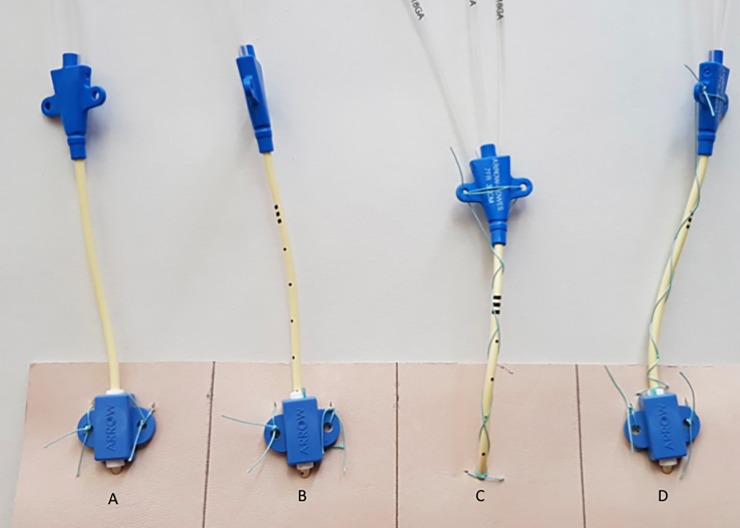
Fixation techniques.From the left to the right, the four fixation techniques used in the present study are presented (A-D). A represents the “standard” technique, B represents the “compression” technique, C represents the “finger trap” technique and D represents the “complete” technique. Details of the compression technique are presented in Fig 2.